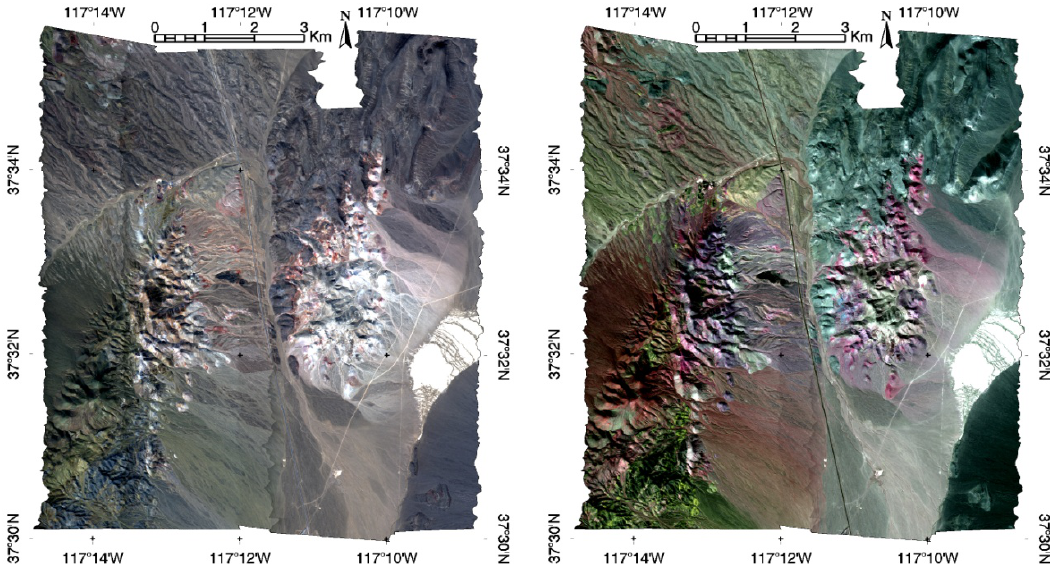
Figure 2. ( Left ) Airborne Visible/Infrared Imaging Spectrometer (AVIRIS) True Color image (0.65, 0.55, 0.45 μ m, RGB) of the Cuprite site; ( Right ) AVIRIS SWIR color image (2.10, 2.20, 2.34 μ m, RGB) of the Cuprite